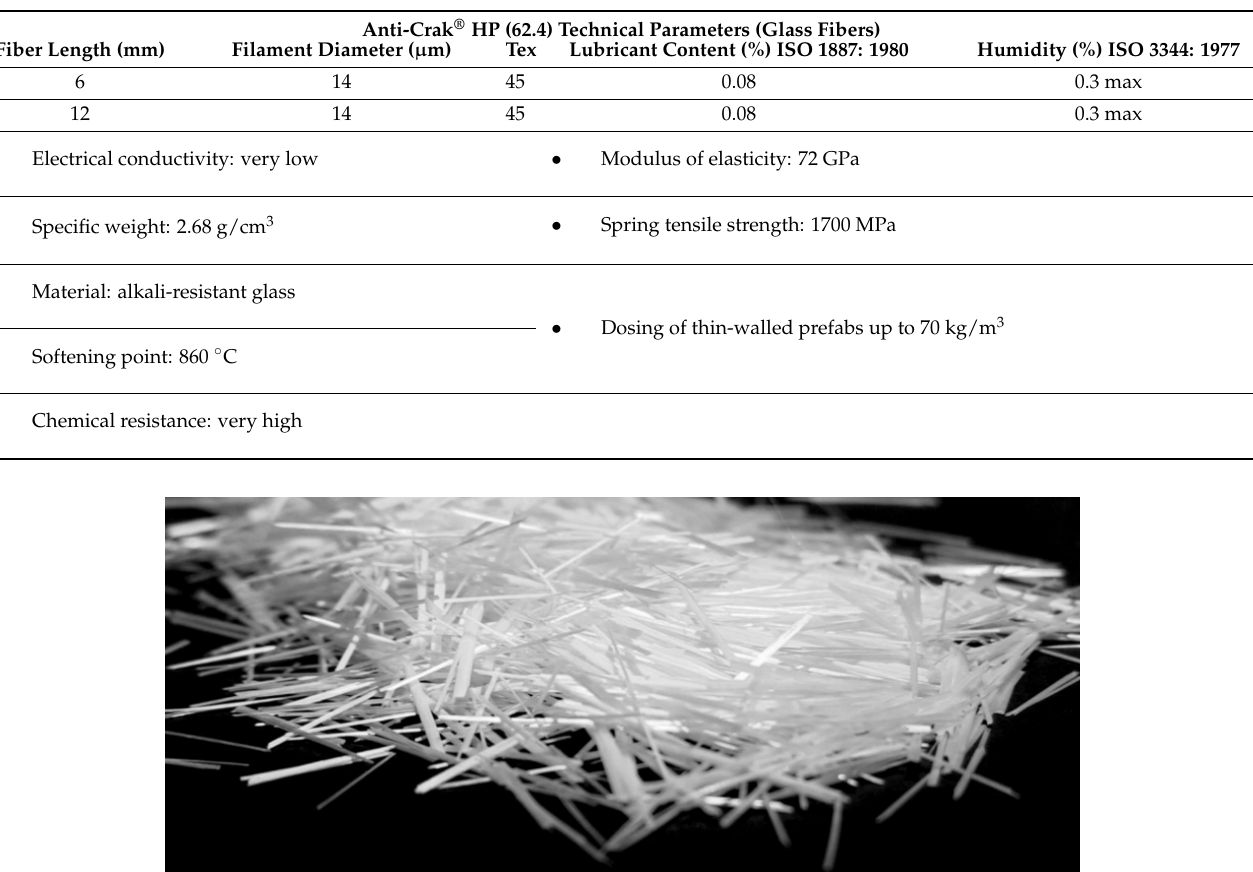
Table 2. Technical parameters of Anti-Crack HP (62.4) glass fibers.